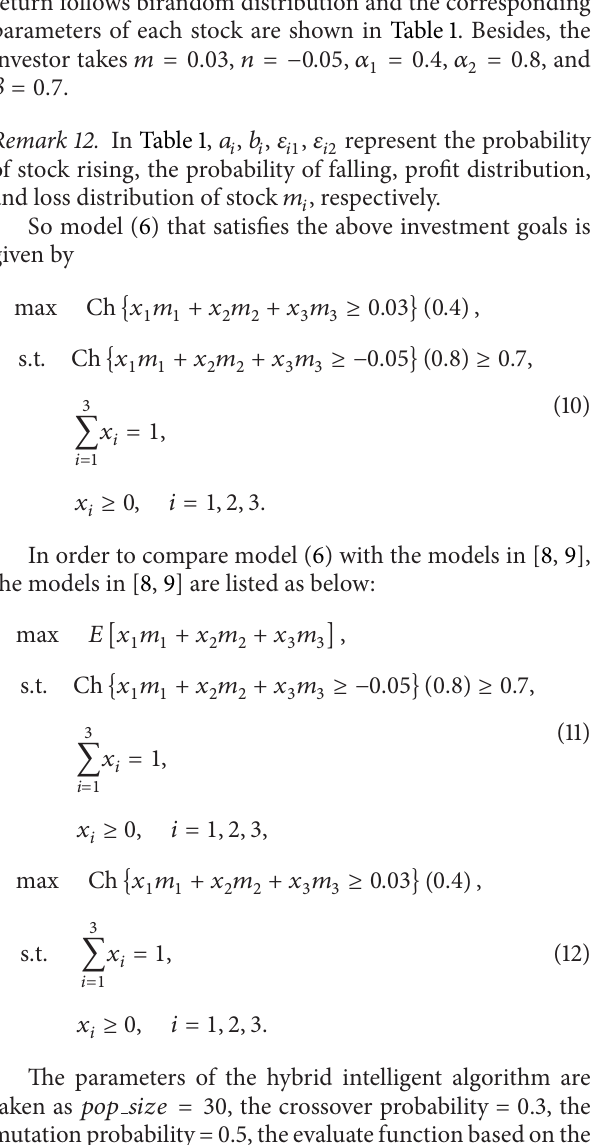
Algorithm 11 (birandom simulation for (5)).